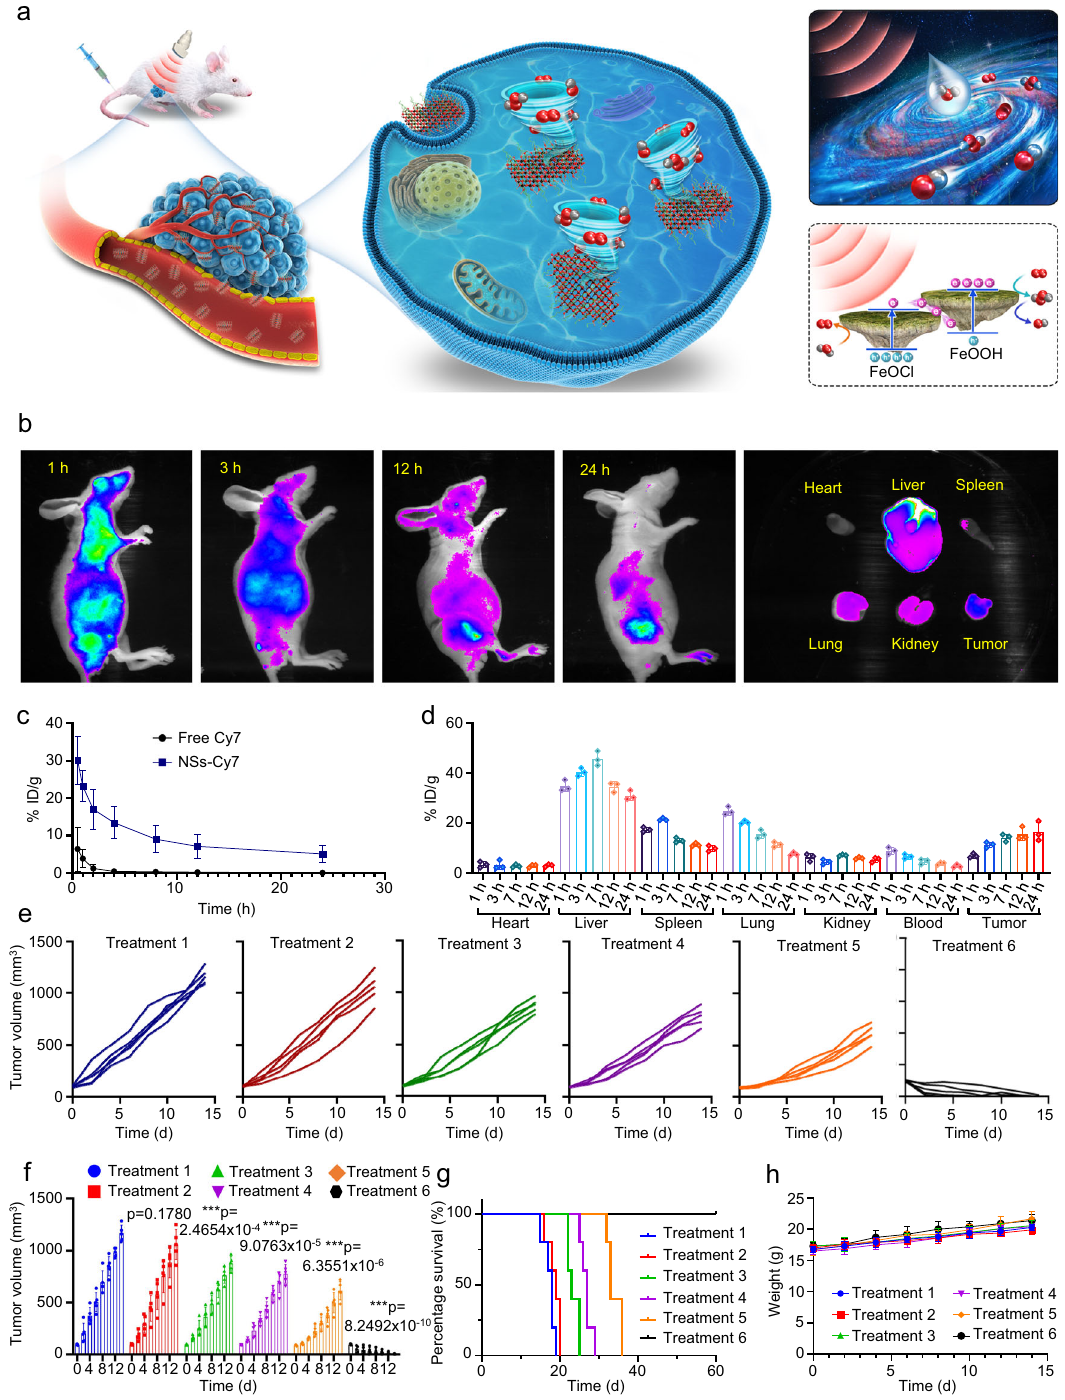
Fig. 8 In vivo imaging and anti-tumor performance of FeOCl NSs and FeOCl/FeOOH NSs. a Schematic diagram of treatment. b In vivo fl uorescence images of nude mice after i.v. administration of NSs, and the ex vivo fl uorescence images of the tumor and major organs at 24 h post-injection of Cy7 loaded FeOCl/FeOOH NSs. Data are presented as mean ± s.d. ( n = 3 biologically independent mice). c Blood circulation of FeOCl/FeOOH NSs. Data are presented as mean ± s.d. ( n = 3 biologically independent mice). d Bio-distribution of FeOCl/FeOOH NSs under different times. Data are presented as mean ± s.d. ( n = 3 biologically independent mice). e Tumor growth curves of MCF7 tumor-bearing nude mice. f Tumor growth curves of MCF7 tumor- bearing nude mice. Data are presented as mean ± s.d. ( n = 5 biologically independent mice). Statistical differences were analyzed by Student ’ s two-sided t - test. g Survival rate of mice undergoing different treatments. h Body weight of mice during treatment. Data are presented as mean ± s.d. ( n = 5 biologically independent mice). The condition for US treatment is 1 MHz, 1 W cm − 2 , 50% duty cycle, 10 min. Source data are provided as a Source Data fi